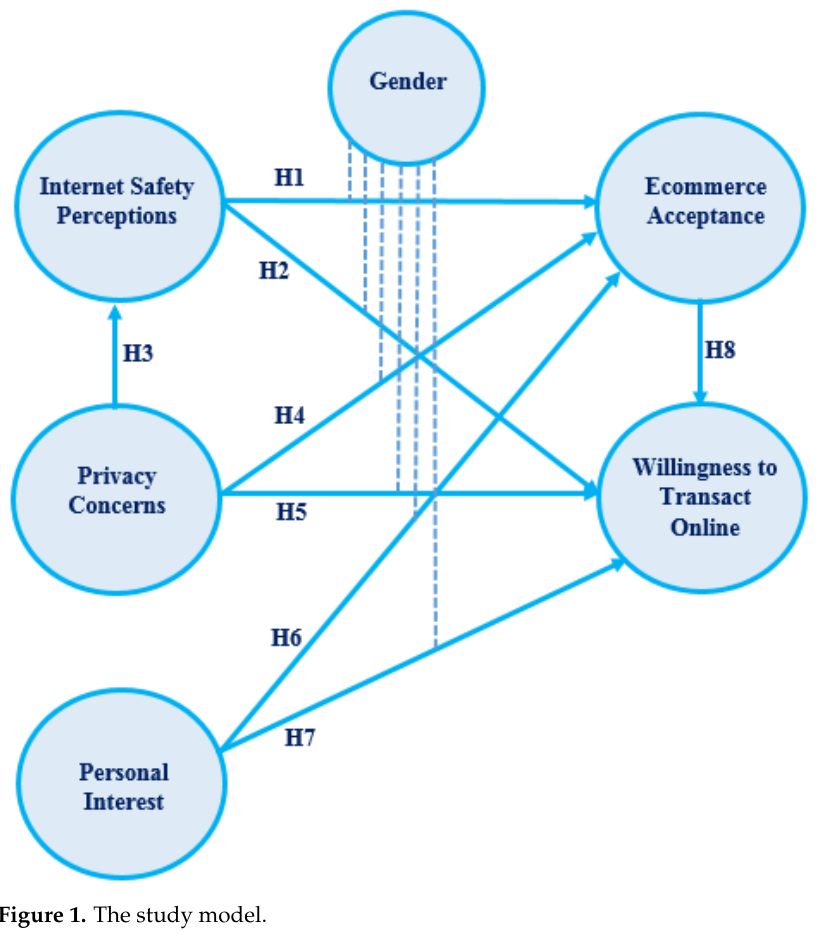
Figure 1. The study model.